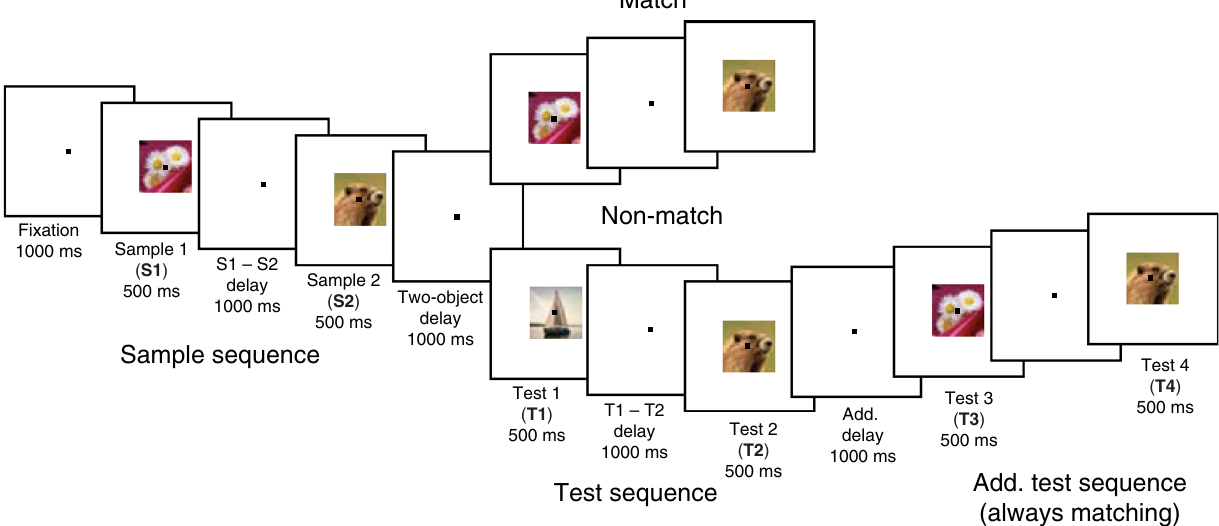
Fig. 1 Experimental setup. The animals held a bar and fi xated at the center of the screen throughout the task. Two sample objects (sample 1 and sample 2) were presented (500 ms), separated by a delay (1000 ms; S1 – S2 delay). After another delay (1000 ms; two-object delay), a test sequence of two objects appeared (test 1 and test 2), separated by a 1000 ms delay (T1 – T2 delay). The animals were trained to release the bar after the second test object only if both the identity and the order of the test objects matched the sample sequence. When the sample and test sequences did not match, the animals had to wait for the subsequent (always matching) test sequence to release the bar. Reused and modi fi ed with permission from